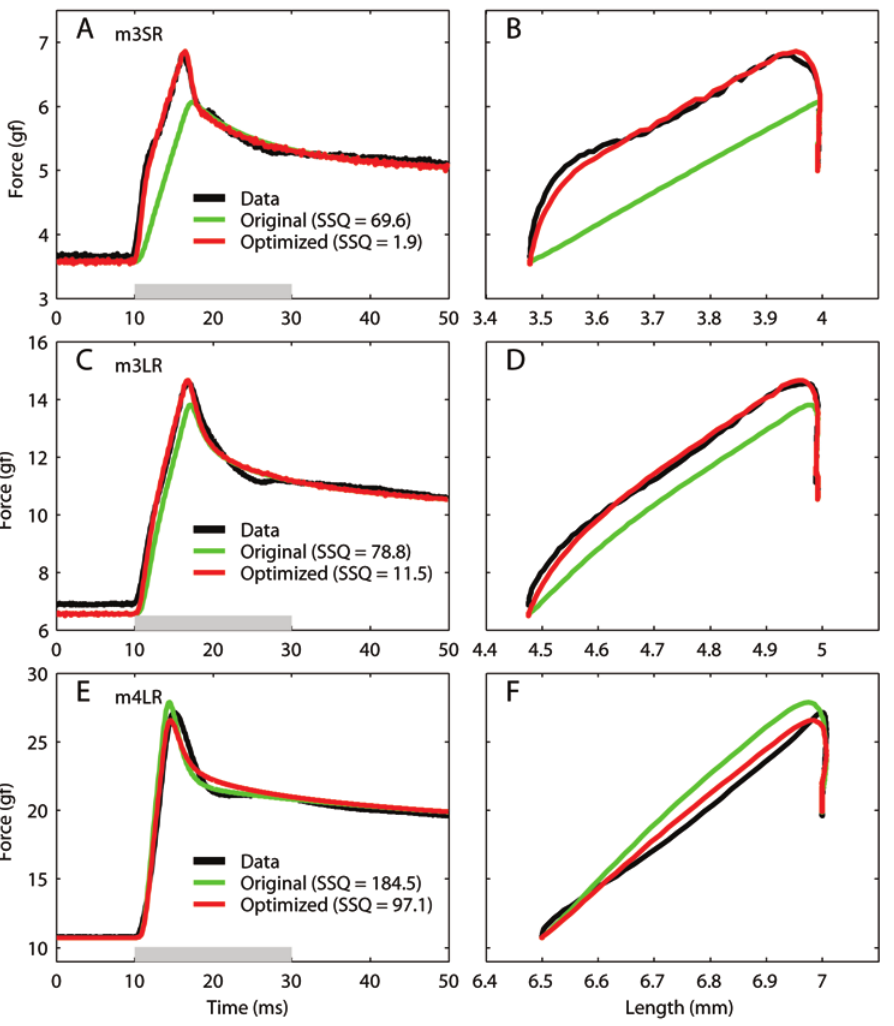
Figure 3. Peri-elongation forces and generalized QLV model fits. Data (black), force predicted by the generalized QLV model using the parameters derived analytically from the E-T fit (green), and force predicted by the generalized QLV model after parameter optimization and addition of a viscous term (red). A : Data for a step at short elongations from the superior rectus in m3. B : Same forces as in A, but plotted as a function of muscle elongation rather than time. The initial rapid rise in force is due to the pure viscosity, which was not part of the original model (green trace). C & D : Same as A & B, but for a step at intermediate elongations from the lateral rectus in m3. E & F : Same as A & B, but for a step at large elongations from the lateral rectus in m4. Note how in this case the fit is not as good, as the force in panel F is convex, whereas the model predictions are always concave. Force scale is different across rows. SSQ: sum of squared residuals (fit – data). doi:10.1371/journal.pone.0006480.g003 PLoS ONE |